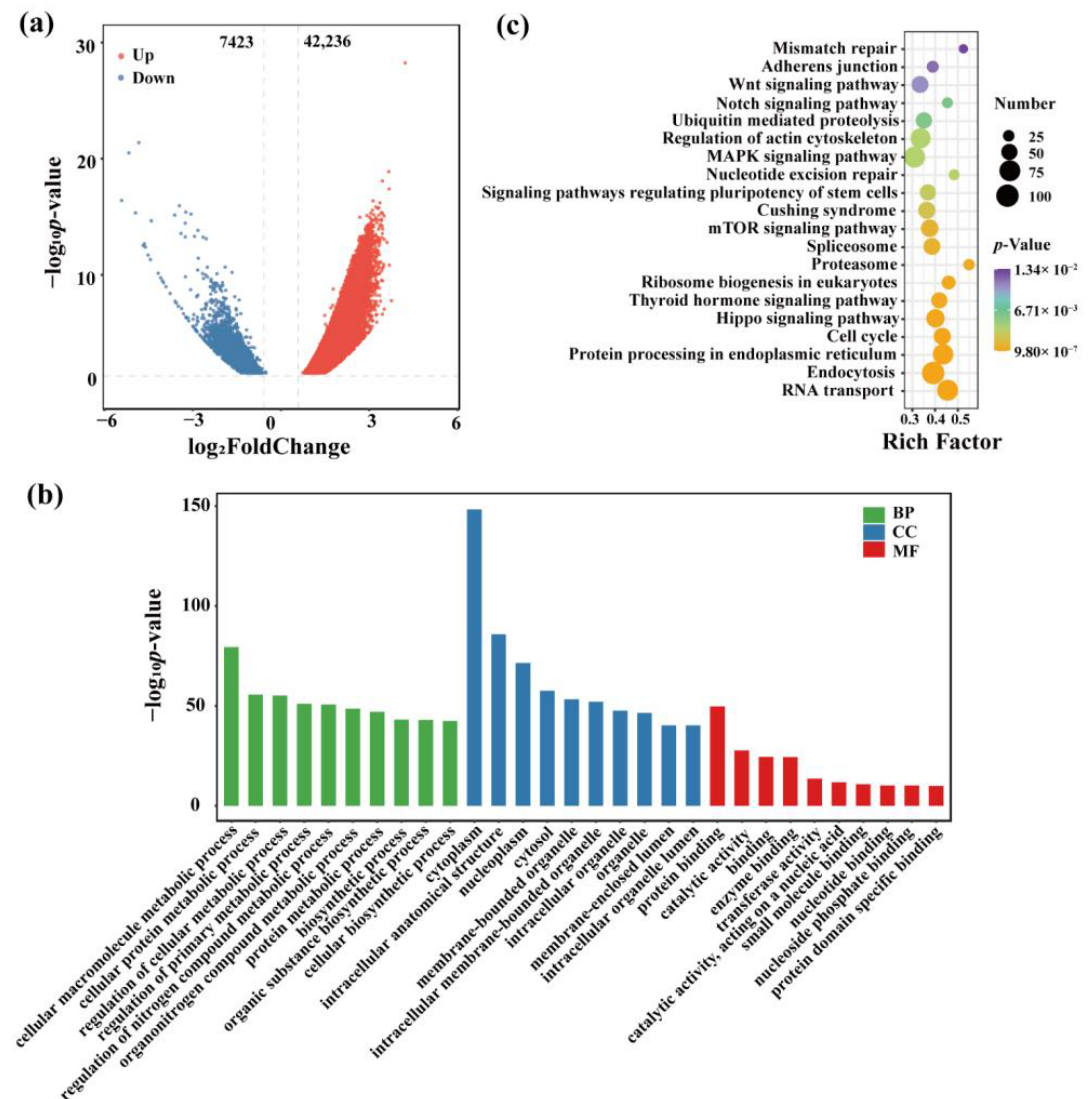
Figure 2. GO/KEGG analyses of the differential OCRs-related genes. ( a ) Volcanic map of the differential OCRs between cattle-yak and yak groups (| log 2 FoldChange | ≥ 0.58, q ≤ 0.05), ( b ) Annotation of the top 30 GO functions of the differential OCRs related genes, ( c ) The top 20 KEGG pathways of the differential OCRs related genes.